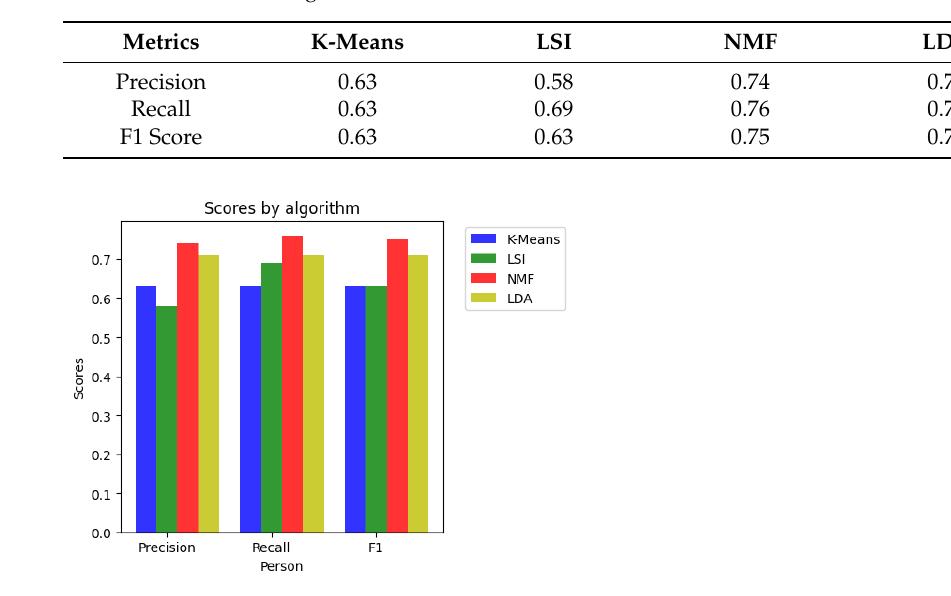
Figure 4. Results of the algorithms: K-means, LSI, NMF,